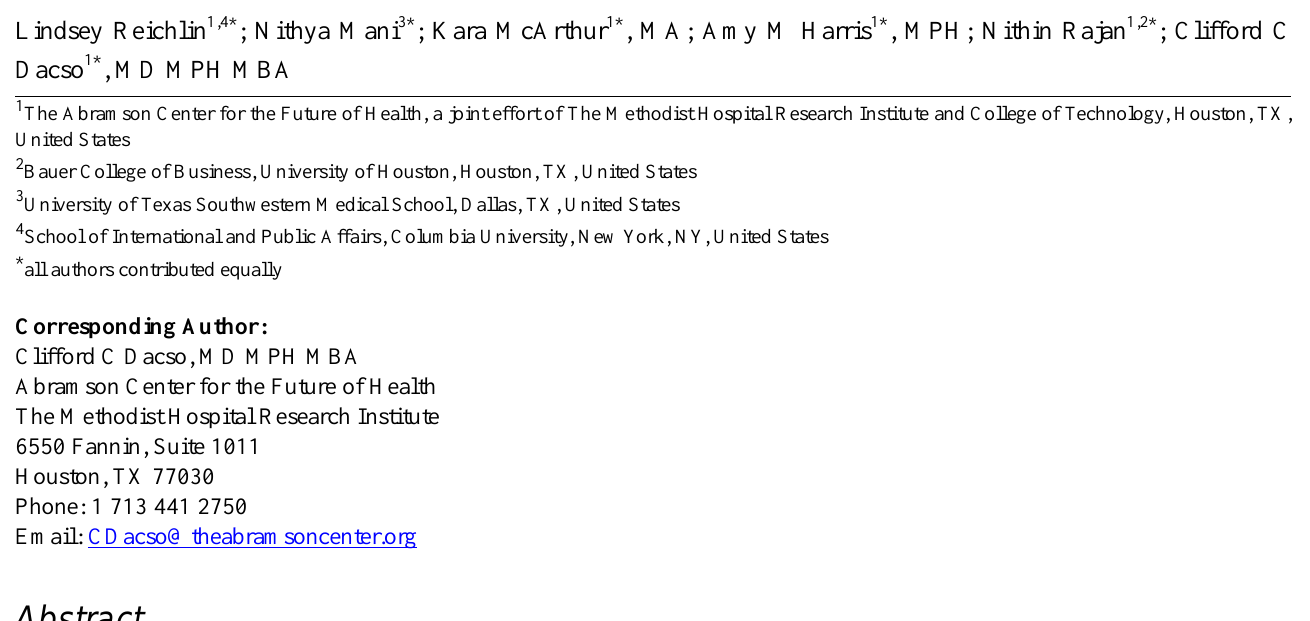
serious games; prostate cancer; shared decision-making;